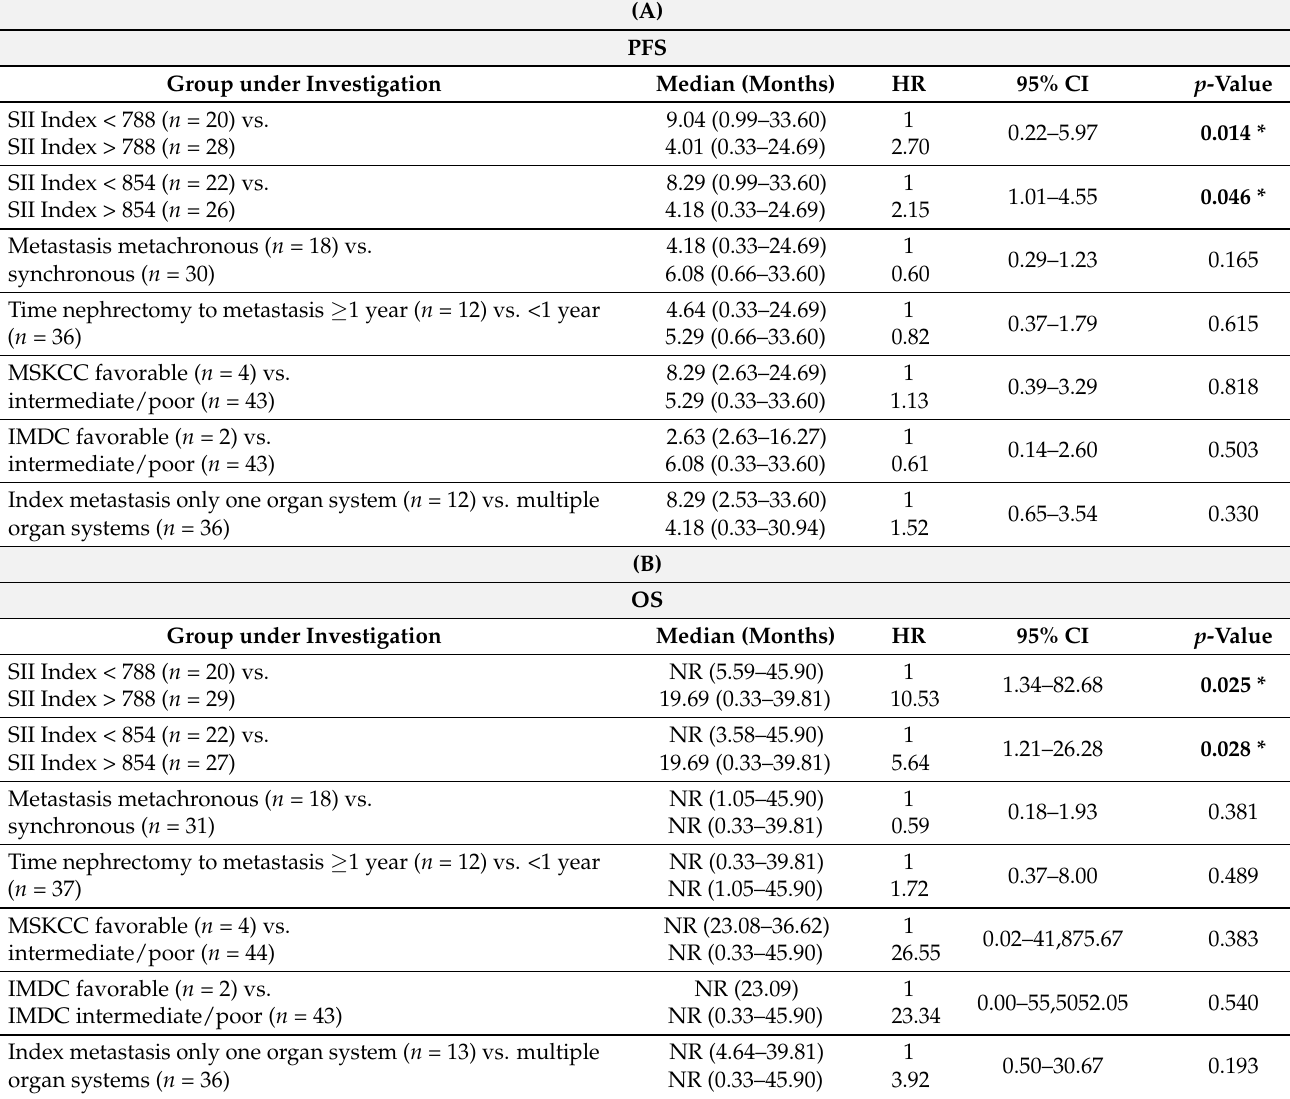
Table 2. ( A ) Overview of calculated PFS depending on clinical parameters as well as SII score and univariate analyses of PFS, defined as time from start ipilimumab plus nivolumab to tumor progression. ( B ) Univariate analysis of OS, defined as time from start ipilimumab plus nivolumab to death/last follow-up, depending on clinical parameters and SII